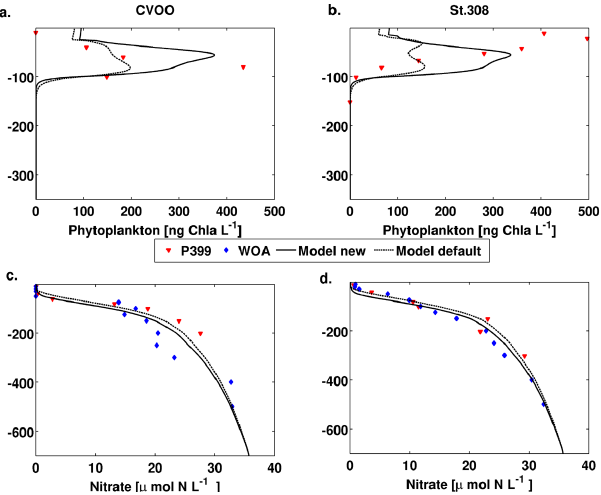
Fig. A2. Phytoplankton (a, b) and nutrient (c, d) concentrations in April (a, c) and June (b, d) [ngChl a L − 1 ] – model-predicted (black solid lines new and dashed lines default parameter setup) and ob- served (red markers) profiles. Observations were taken from the Po- seidon cruise P399/2 in 2010. Simulated phytoplankton concentra- tions have been converted to chlorophyll using a vertically depen- dent C:Chl ratio (e.g. Hense and Beckmann, 2008) and the Redfield ratio for conversion from carbon to